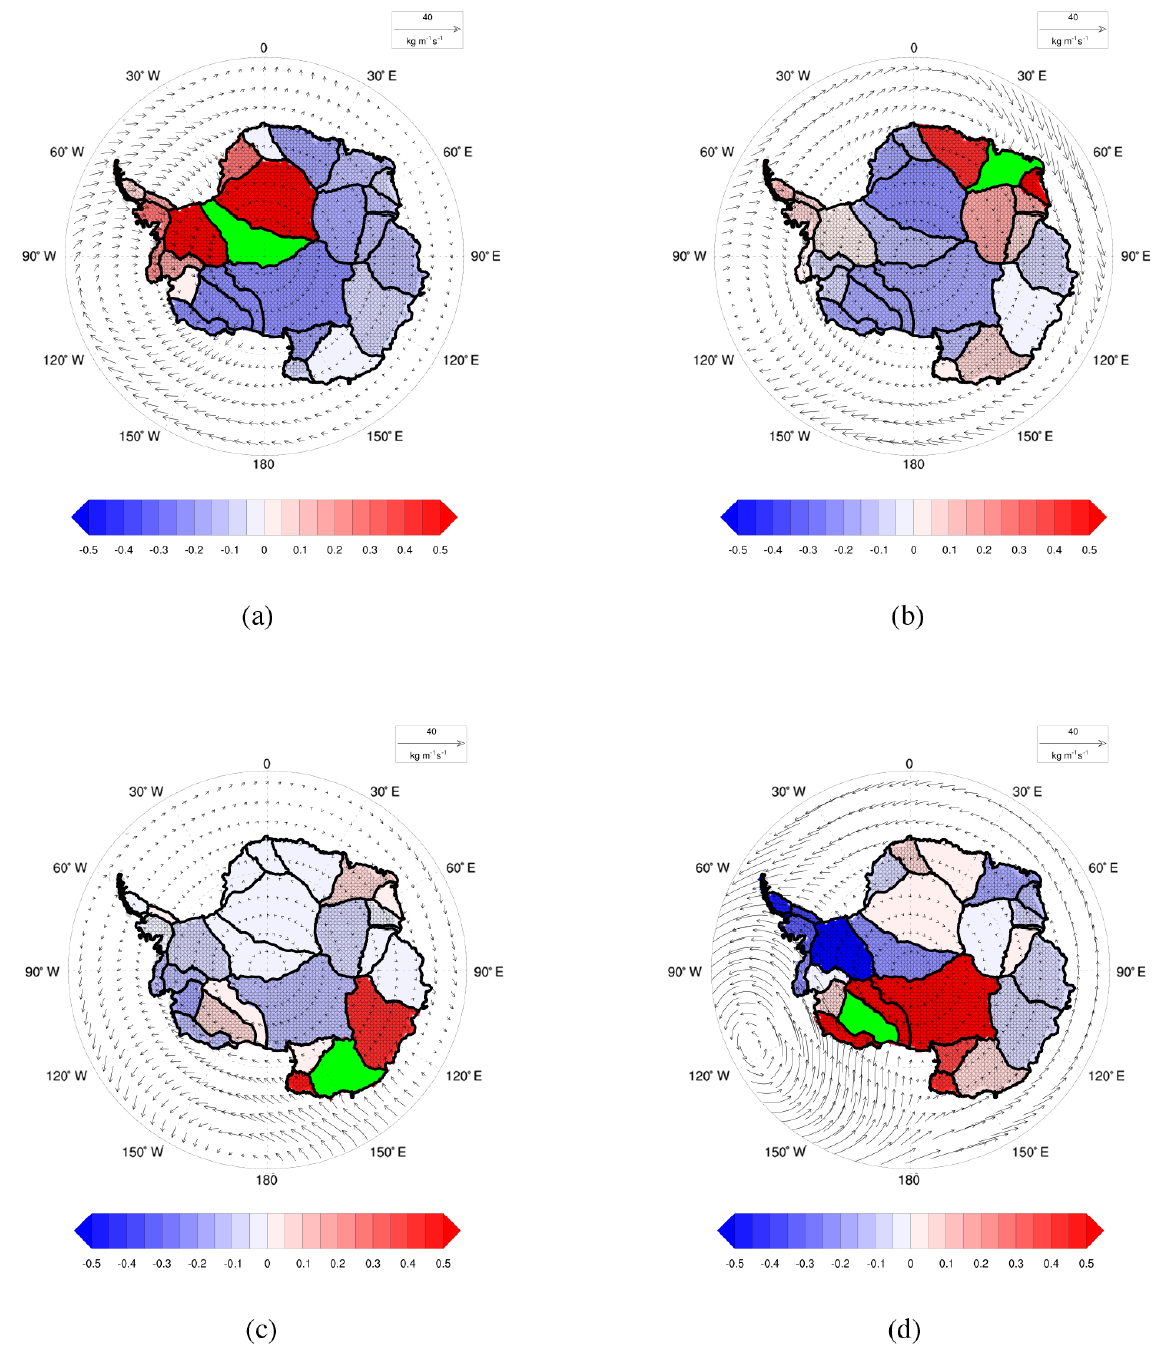
Figure 4. (a–d) Basin-specific coloring: inter-basin annual integrated precipitation zero-lag correlations for basins 2, 7, 14 and 19 (in green). Stippling represents the presence of inter-basin significance at the 95% level. Arrows: vector differences between basin-specific composite vertically integrated moisture transport climatologies (high minus low basin-specific integrated